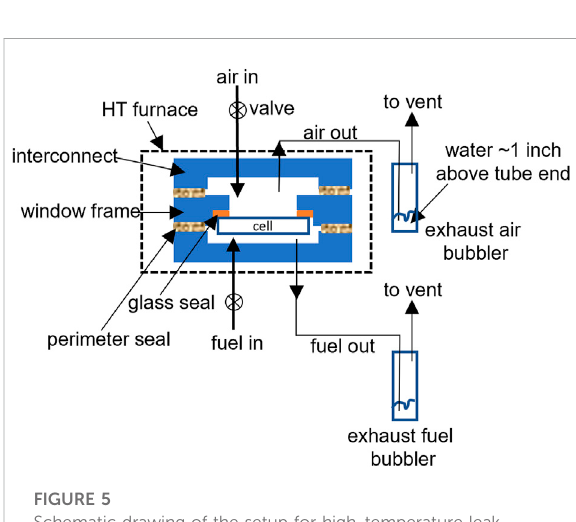
FIGURE 5 Schematic drawing of the setup for high-temperature leak test by cross-bubbling.